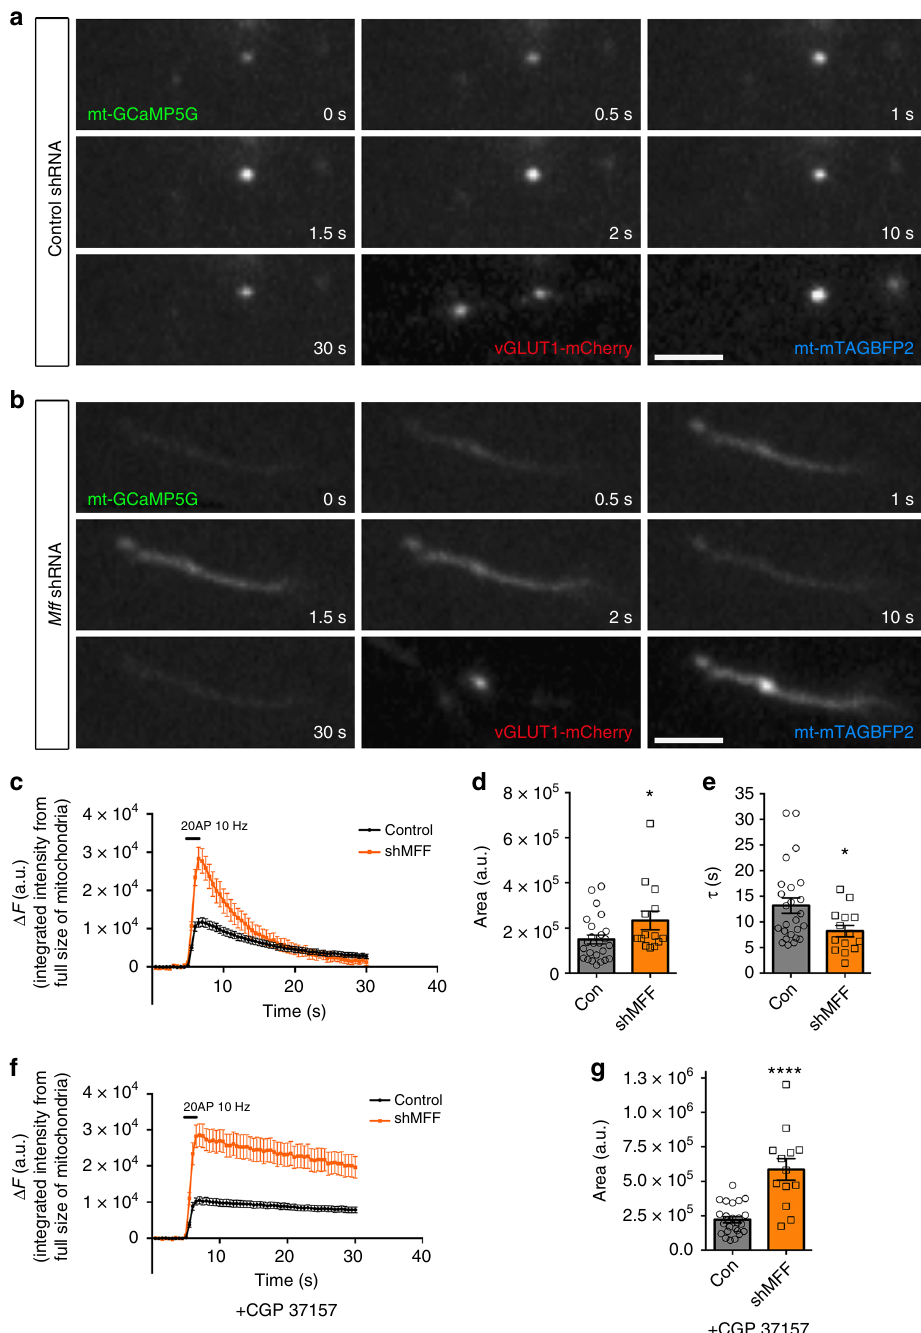
Fig. 6 Elongated mitochondria in Mff knockdown axons uptake more Ca 2 + upon evoked neurotransmitter release from presynaptic sites. Presynaptic mitochondrial Ca 2 + was monitored using mitochondria-targeted GCaMP5G (mt-GCaMP5G) with VGLUT1-mCherry and mt-mTAGBFP2 in cortical cultured neurons following EUE at E15.5 and imaged at 17-23DIV. a , b Cropped time-lapse images of mt-GCaMP5G with repetitive stimulation (20AP at 10 Hz) in control and Mff knockdown axons. Mitochondrial Ca 2 + diffuses along elongated mitochondria from a presynaptic site in an Mff knockdown axon (See Supplementary Fig. 6 and Supplementary Movie 4) and extrudes faster than small mitochondria. c Integrated intensity of mt-GCaMP5G signals from full-length mitochondria associated with single presynaptic sites is plotted with mean ± sem. d Quanti fi cation of [Ca 2 + ] mt (area under the curve) show long mitochondria with a single presynaptic bouton in Mff knockdown axons accumulate signi fi cantly more [Ca 2 + ] mt than small mitochondria in control axons. * p < 0.05, Mann – Whitney test. e Long mitochondria show faster decay than control mitochondria. * p < 0.05, Mann – Whitney test. f – g Blocking extrusion of mitochondrial Ca 2 + by inhibition of mitochondrial Na + /Ca 2 + exchanger (NCLX) causes more accumulation of [Ca 2 + ] mt in long mitochondria. Images were captured after CGP 37157 incubation (10 µ M, 3 min) from the same axons in c . All bar graphs are represented with mean ± sem. n control = 7 dishes, 25 mitochondria; n MFF shRNA = 11 dishes, 14 mitochondria. **** p < 0.0001, Unpaired t -test. Scale bars represent the following lengths: 5 µ